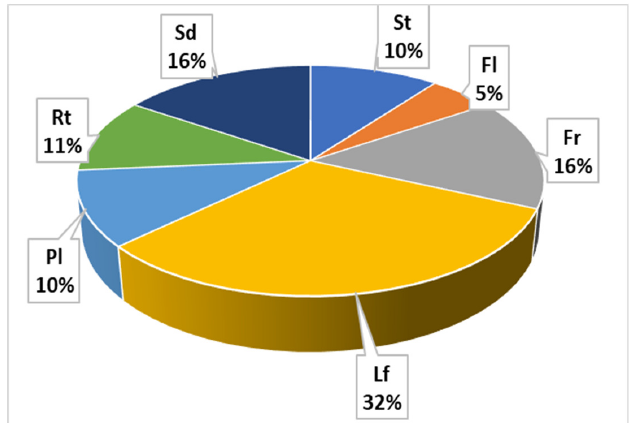
Figure 4. Useful parts of the medicinal plants used by the Monpas of Arunachal Pradesh in curing ailments